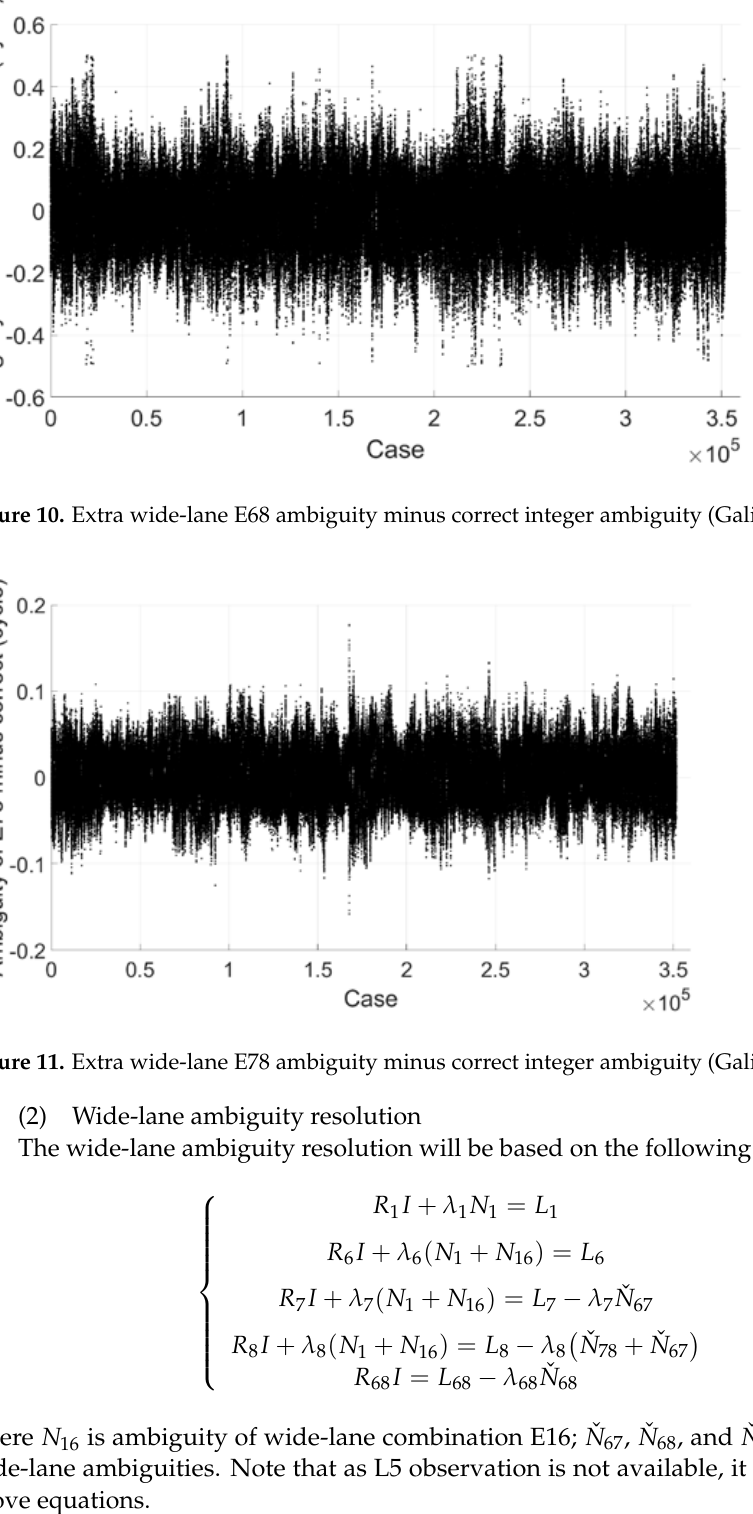
Figure 9. Extra wide-lane E67 ambiguity minus correct integer ambiguity (Galileo).